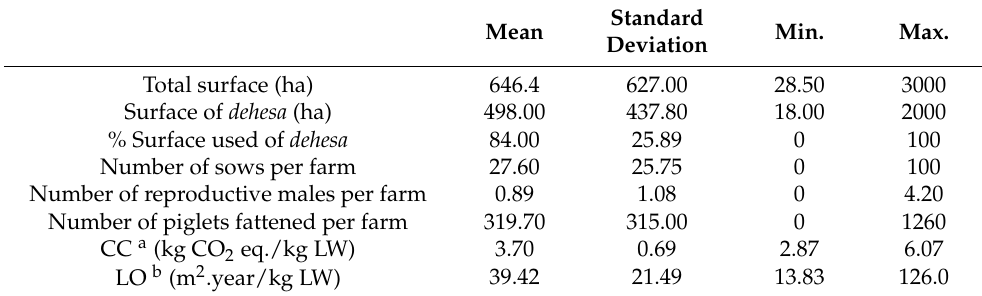
Table 2. General information of the participant Iberian pig farms ( n = 35).